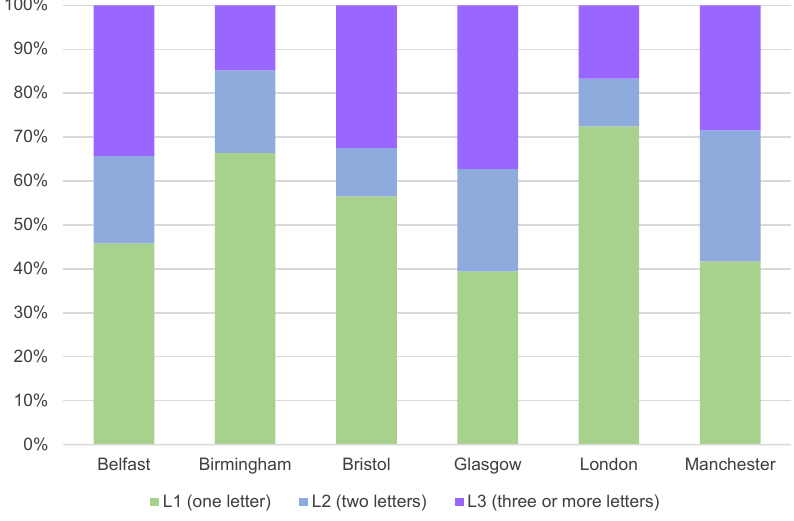
Figure 12: Distribution of fingerspelling-related tokens across nativisation model (L only) per